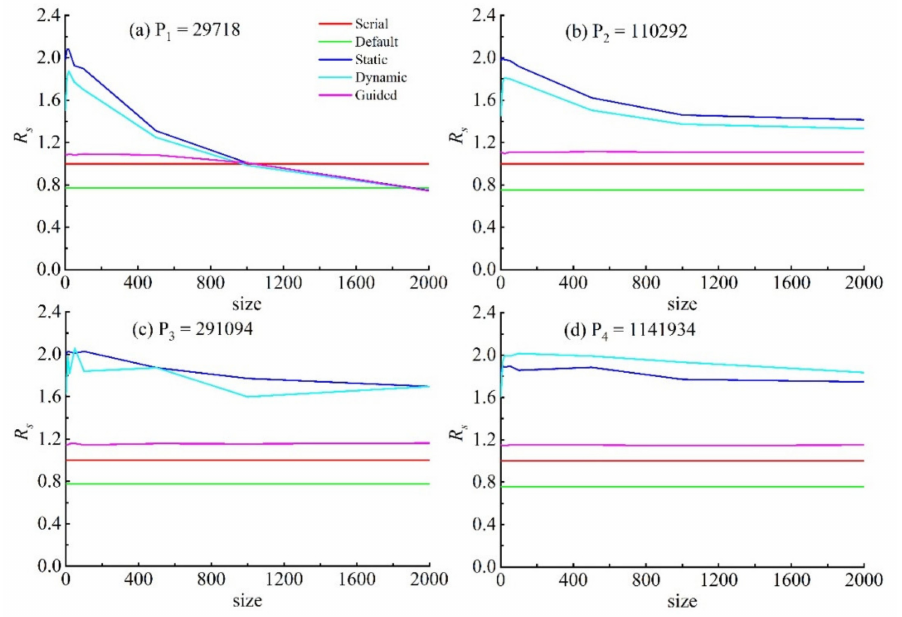
Figure 3. Parallel speedup of the